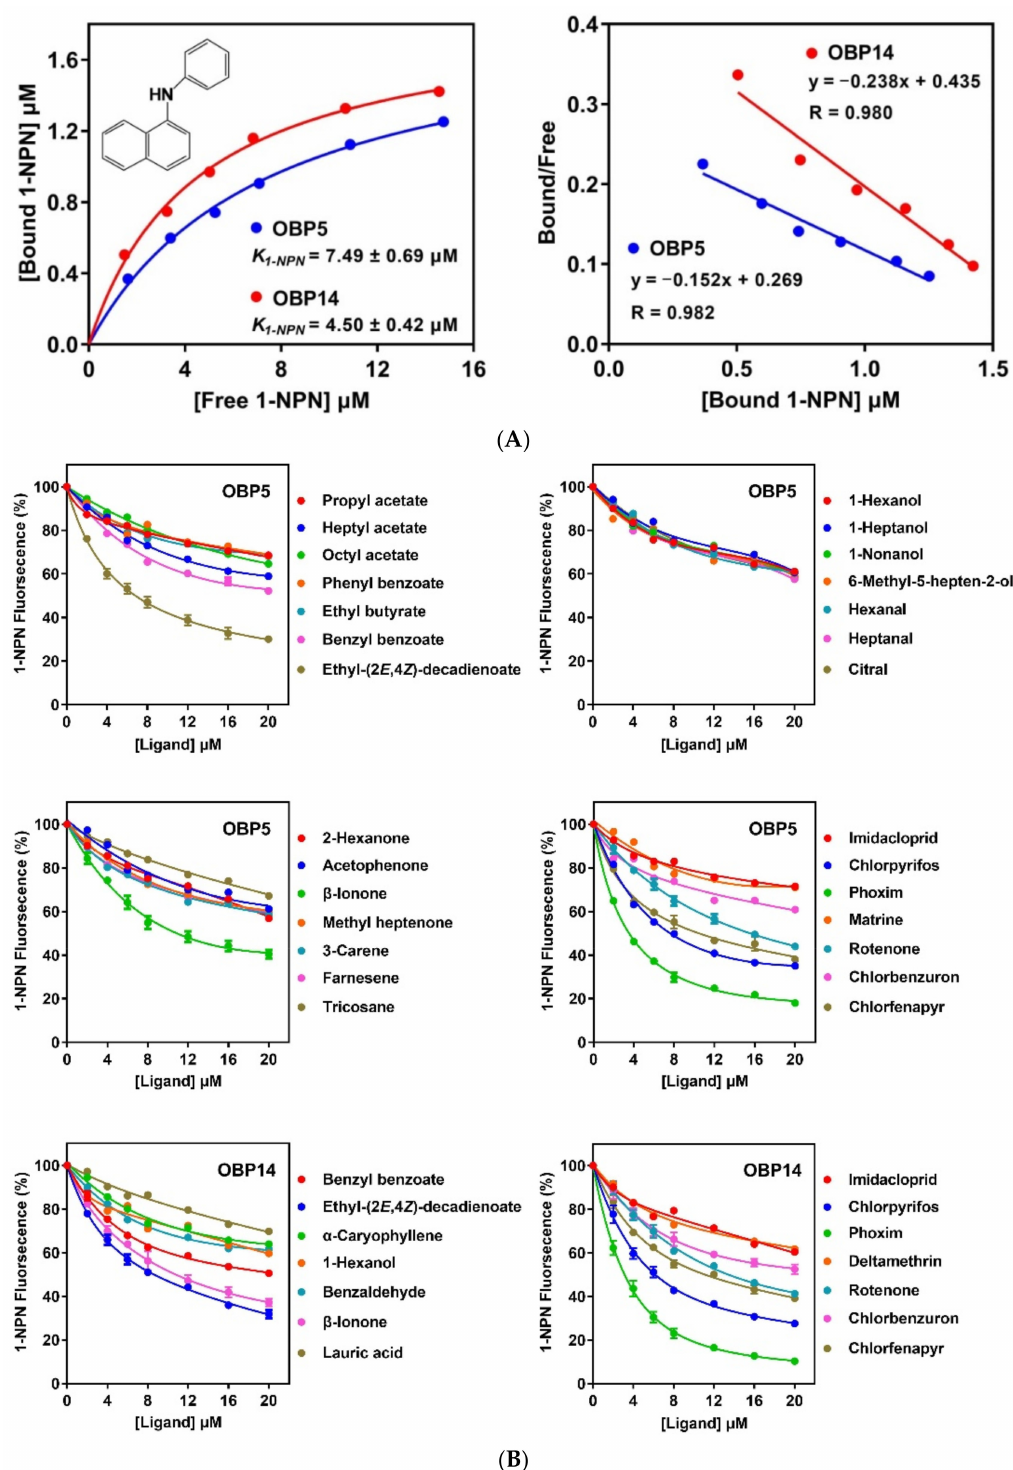
Figure 4. Binding property of selected ligands to two DabiOBPs in D. abietella . ( A ) Binding of two DabiOBPs to 1-NPN and relative Scatchard plots. ( B ) Competitive binding curves of two DabiOBPs to some ligands. For the ligands replacing more than 50% of 1-NPN fluorescence, three replicates were conducted. Each data point represents mean ±